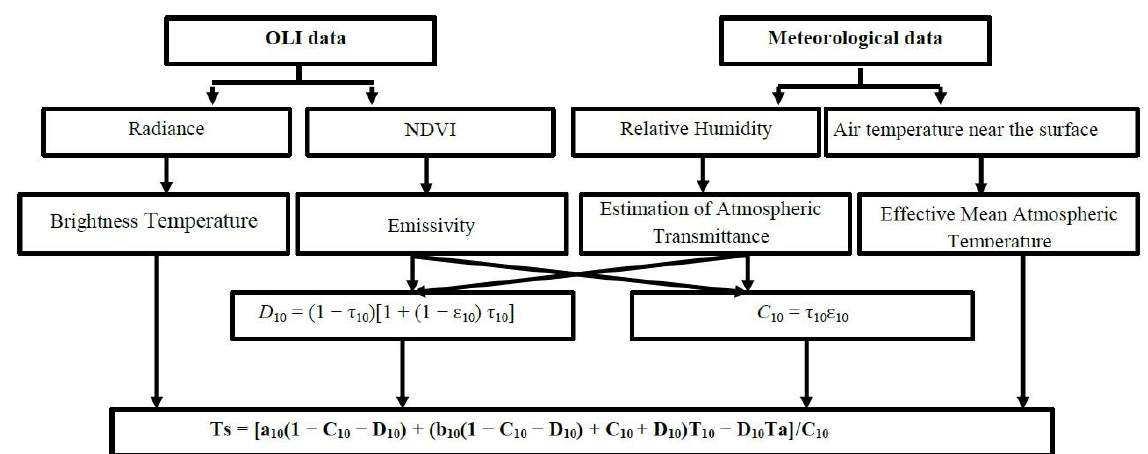
Figure 2. Mono-window algorithm flowchart for land surface temperature retrieval from Landsat satellite images